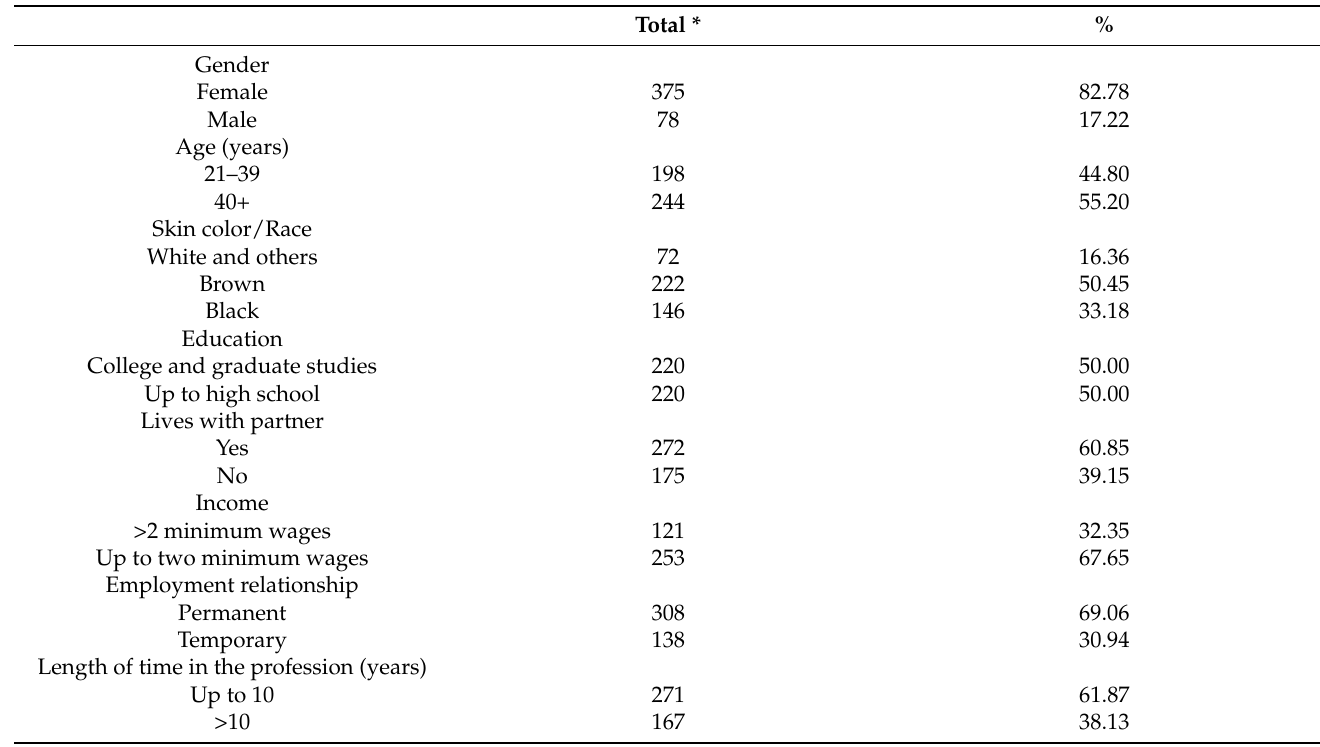
Table 1. Sociodemographic and occupational characteristics of the health workers in Bahia, Brazil in